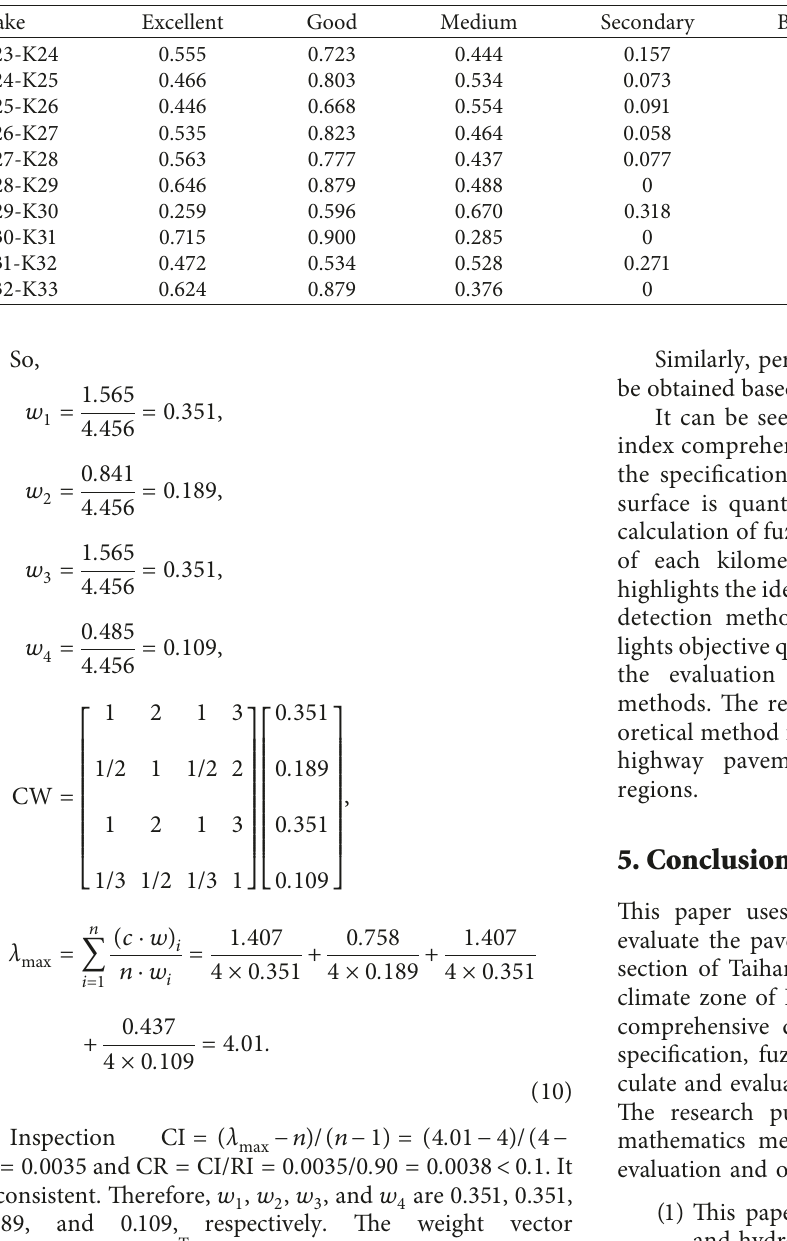
Table 4: Road performance evaluation results of K23 ∼ K33